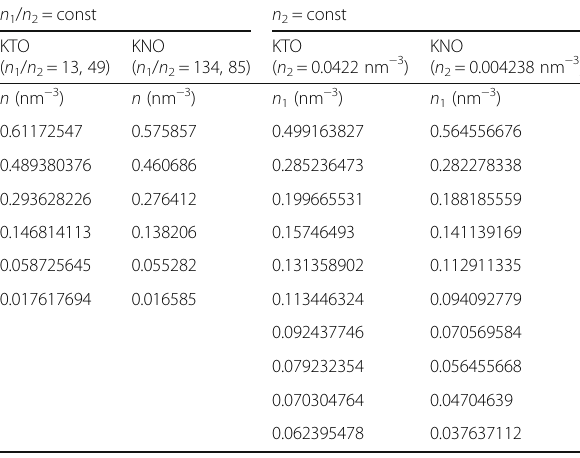
Table 2 Concentrations for which the calculations